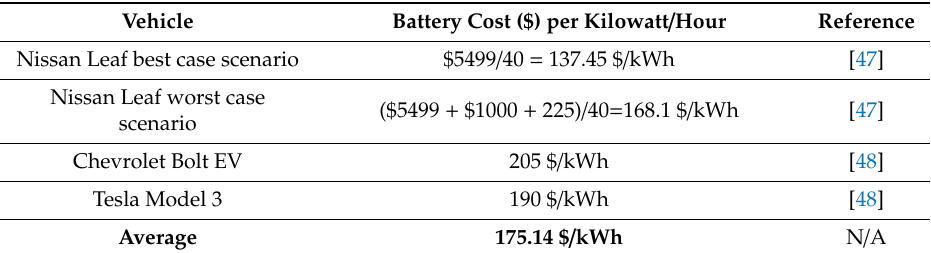
Table 2. Average battery cost per kilowatt /